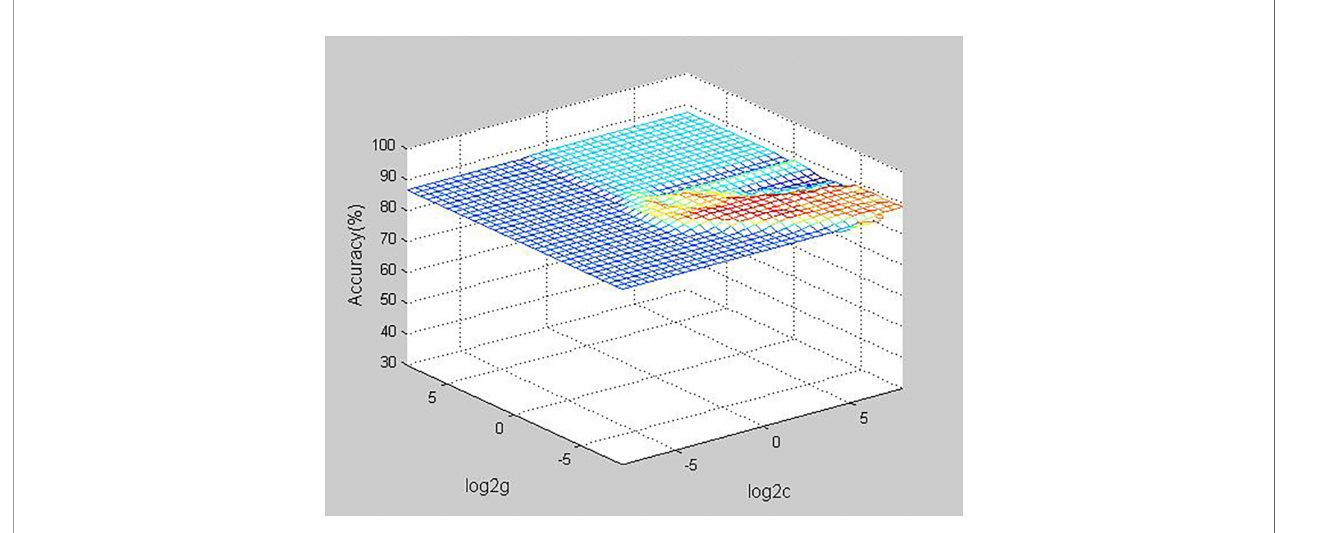
FIGURE 2 | D view of the predictive value for the model (the best parameter c is 16, the parameter g is 0.0884, the parameter b is -0.5531).